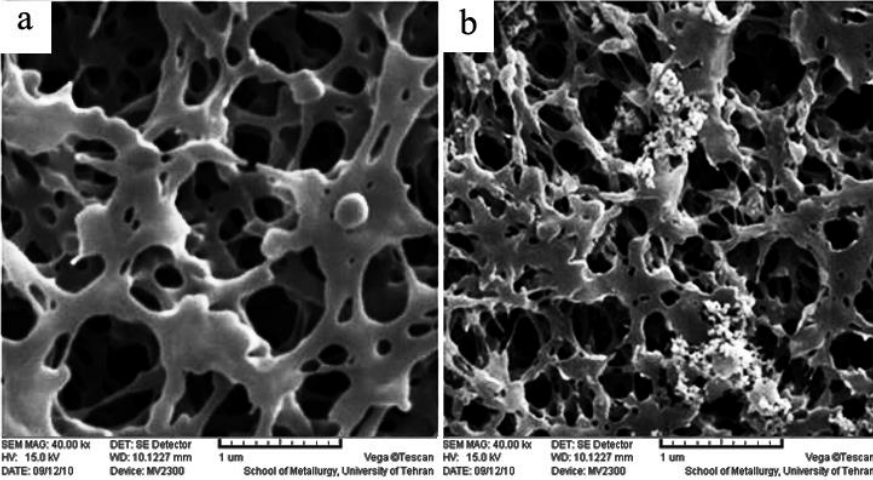
Figure 1. Scanning electron microscope (SEM) images of inactivated PPM ( a ) PPM/TiO 2 ( b ).